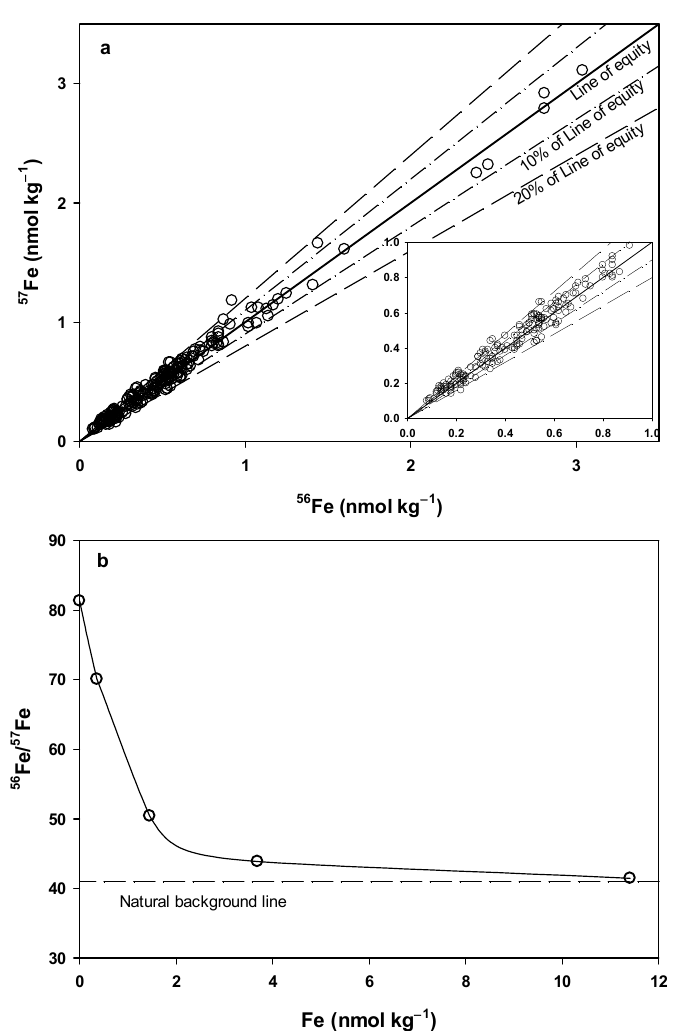
Figure 2. ( a ) Measured Fe concentrations, calculated based on 57 Fe and 56 Fe masses, follow the line of equity. ( b ) measured 56 Fe/ 57 Fe ratios are presented for a range of Fe concentration.